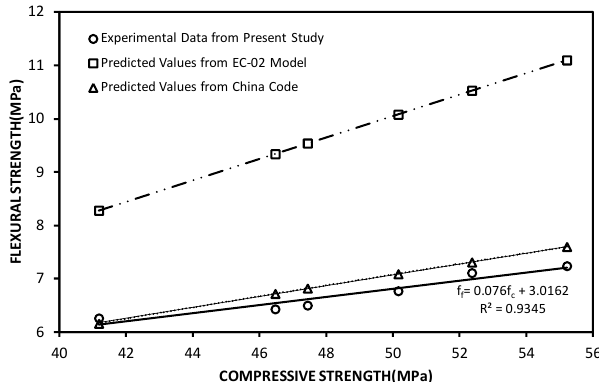
Figure 8. Relationship between compressive strength and flexural strength of concrete.